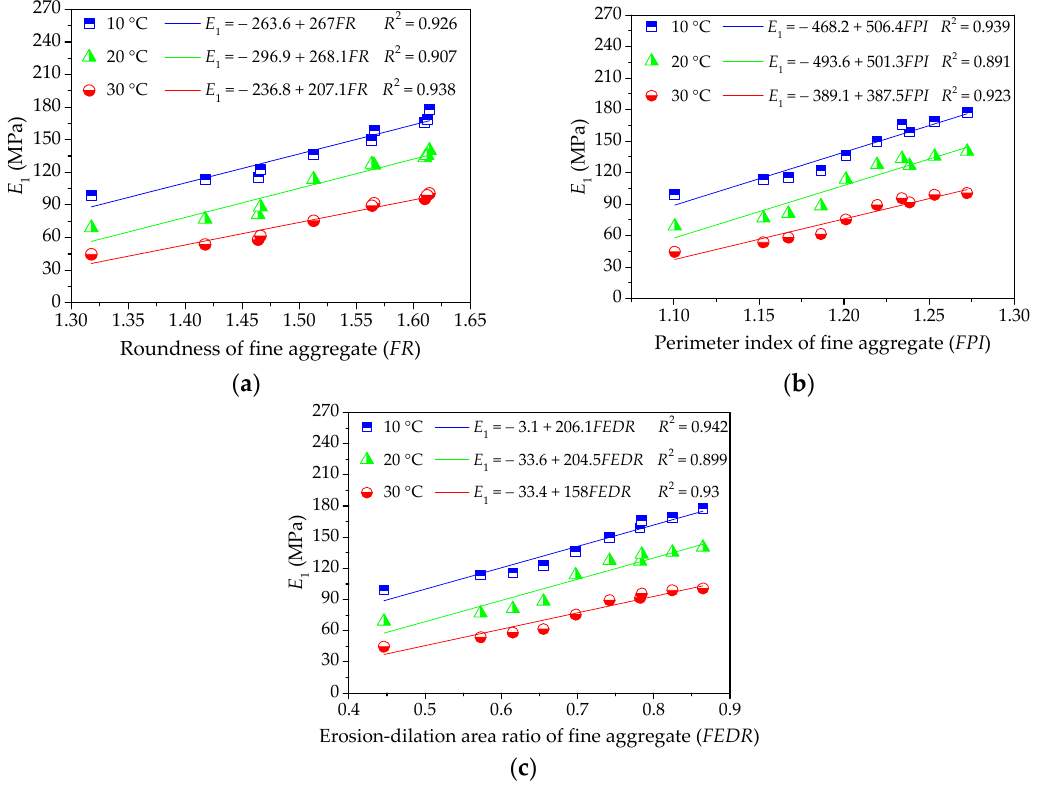
Figure 6. Influences of fine aggregate morphological characteristics of on E 1 of asphalt mortar: ( a ) Shape ( FR ); ( b ) Angularity ( FPI ); and, ( c ) Texture ( FEDR ).